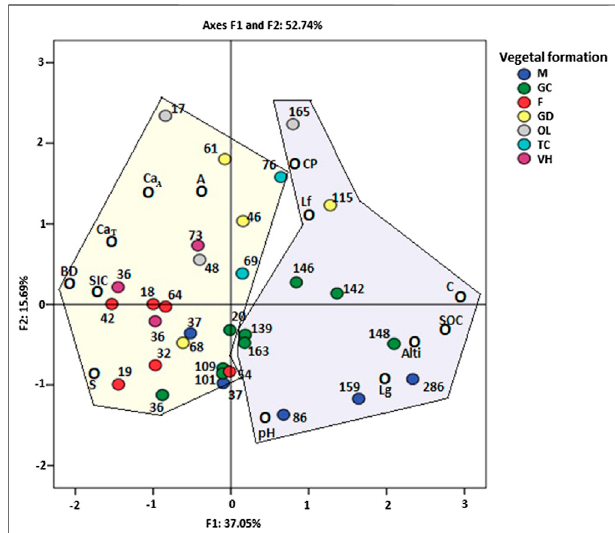
FIGURE 5 | Factorial plan representing the intersection of edaphic variables measured for the sample ’ s locations and different vegetation covers (PCA). A: clay, Lf: fi ne silt, Lg: coarse silt, S: silt, CP: coarse particle, BD: bulk density CaT: total carbonates, CaA:active carbonates, C: carbon, SOC: